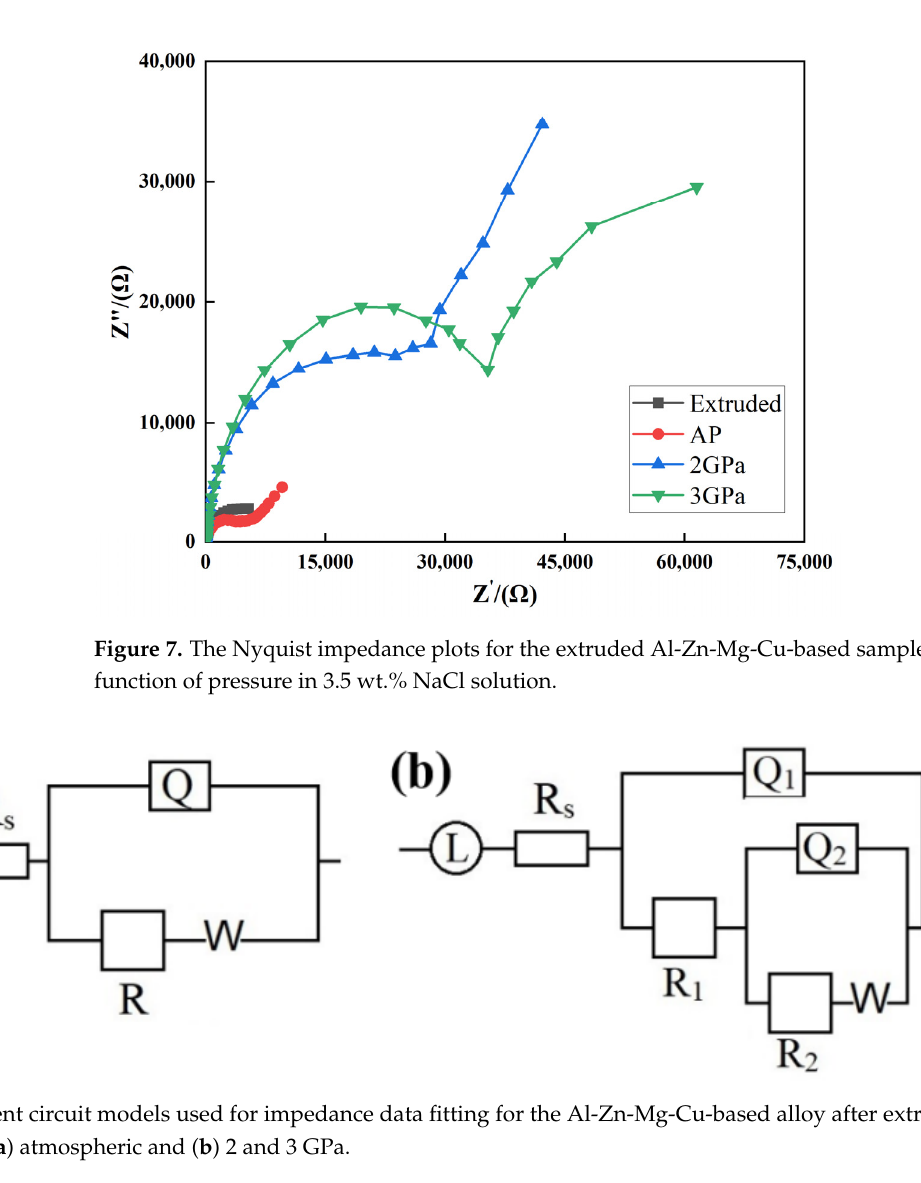
Figure 8. Equivalent circuit models used for impedance data fitting for the Al-Zn-Mg-Cu-based alloy after extrusion and annealing under ( a ) atmospheric and ( b ) 2 and 3 GPa. Table 3. EIS fitting results for the extruded Al-Zn-Mg-Cu alloy annealed at different pressures. Pressure